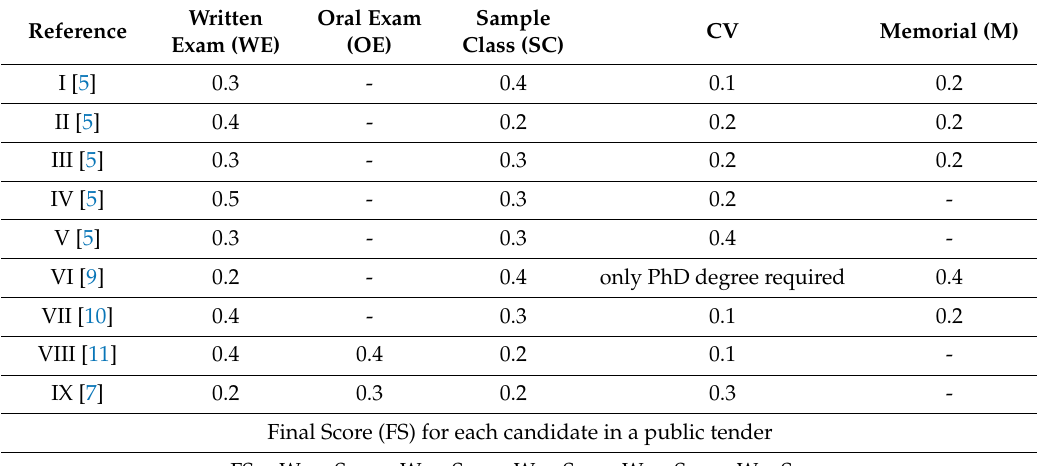
Table 1. Weight distribution for distinct public tender assessment criteria found in the